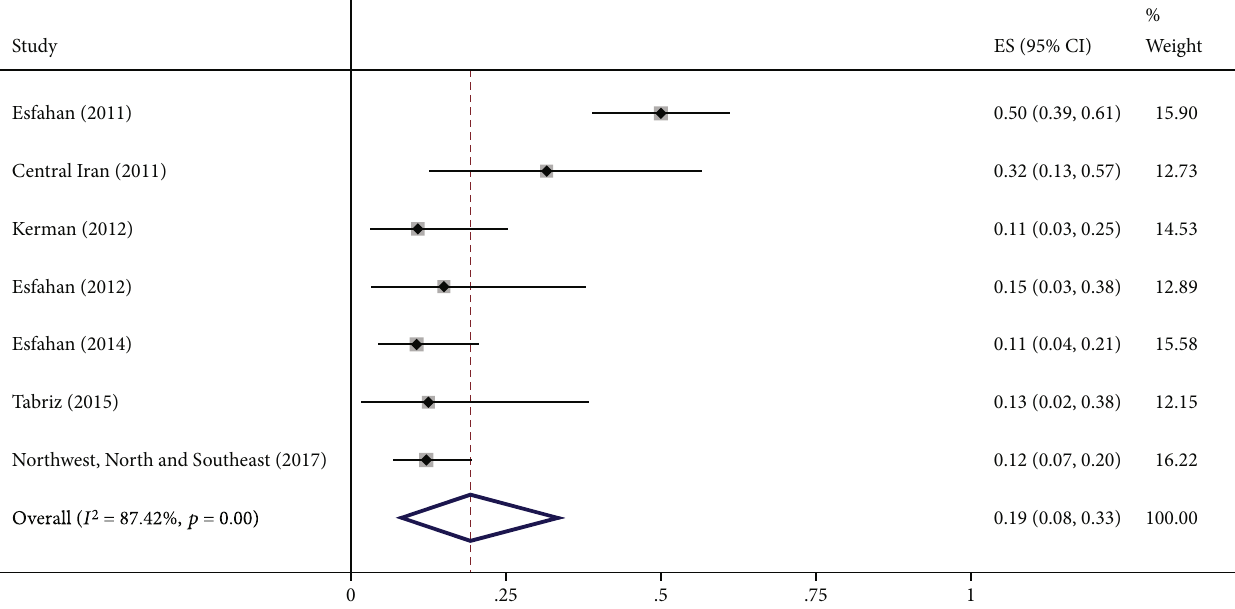
genotype prevalence in animals. 6